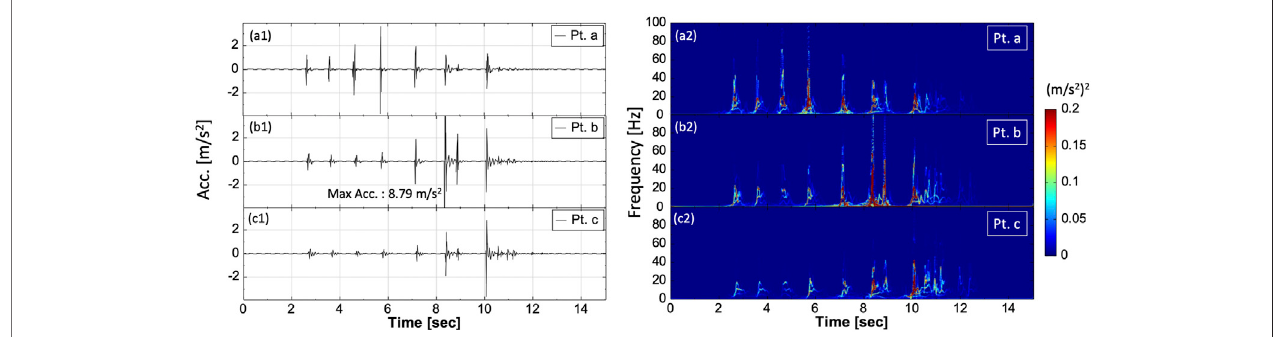
FIGURE 5 | Seismic signals and their corresponding time – frequency spectra with respect tothe monitored points a, b,and c of the single large rockfall simulation.